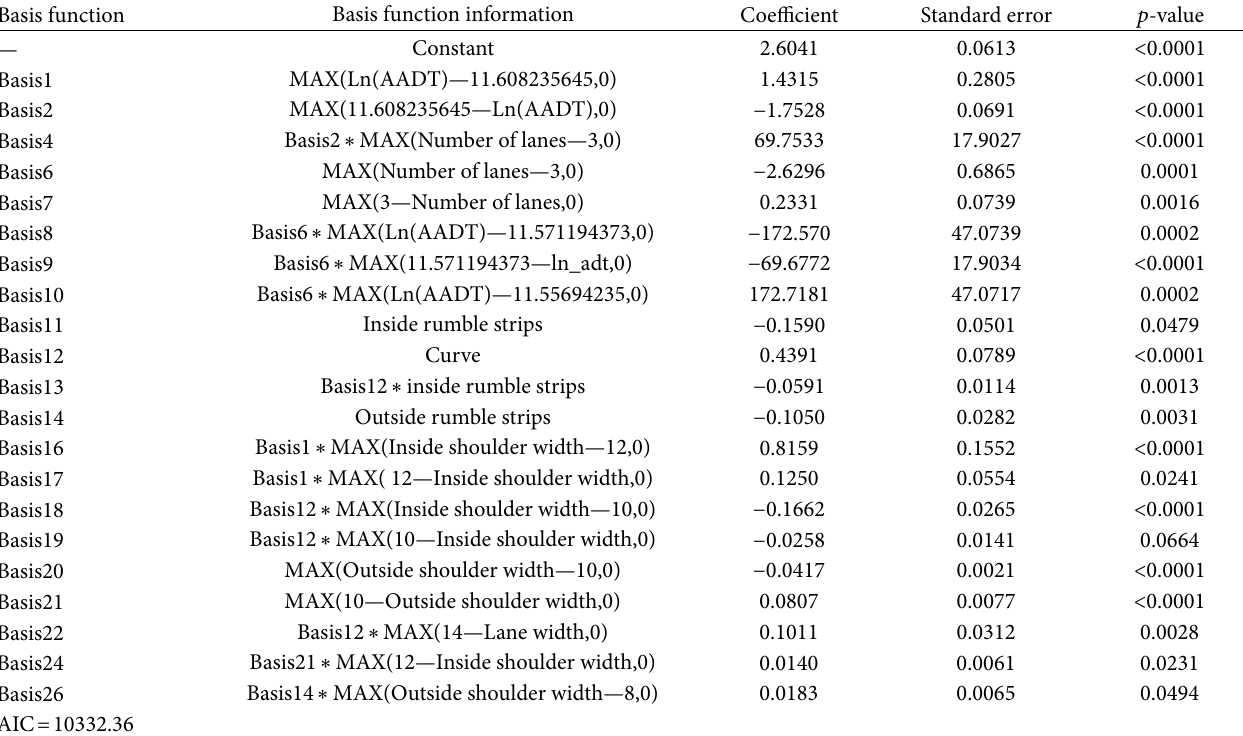
Table 2: MARS model for large truck-involved